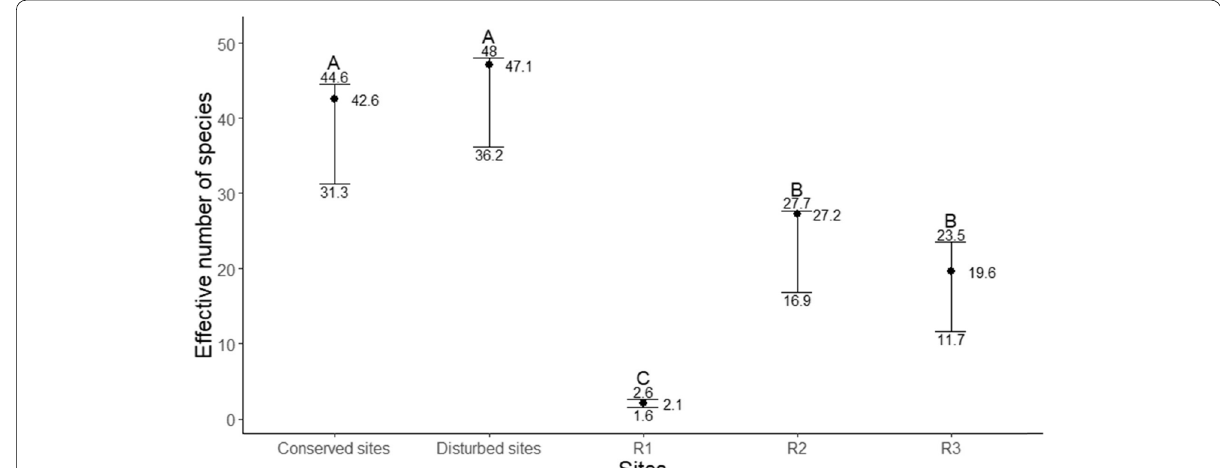
Fig. 2 95% Confidence Intervals of arthropod diversity in conserved, disturbed, and restored sites in the PSAER, based on 857 arthropods in total. Conserved and disturbed sites were grouped respectively to facilitate the interpretation. Captures in all conserved and disturbed sites were pooled and treated as just one site, in each case. Dots represent the effective number of RTUs obtained through the Shannon–Weaver entropy index calculated from our real data, which is right sided of the bar. Lower and upper bar represents minimum, and maximum obtained through a